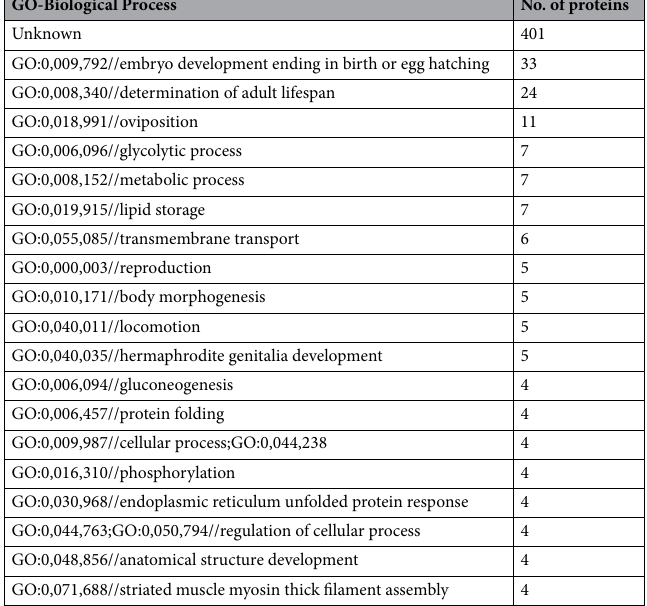
to energy, movement, morphological development, and enzymes for protein structure conformational changes. In addition to GO classification by biological process terms, proteins essential for parasite survival and host immunity evasion were also considered. Proteins relating to oxidation–reduction, proteinase-protease inhibi- tors, structure-movement, and energy were identified in the aL3G protein profile. The top 10 most abundant G. spinigerum proteins involved in these four categories are shown in Fig. 3. Glutathione S-transferase (emPAI of 0.37), peroxiredoxin (emPAI of 0.19), and nucleoredoxin (emPAI of 0.14) were the major antioxidant proteins expressed in aL3Gs. The most prevalent proteases were zinc metalloproteinase nas-14 (emPAI of 1.37), matrix metalloproteinase-like protein (emPAI of 1.13), and cathepsin B-like cysteine proteinase 6 (emPAI of 0.14), while the most abundant protease inhibitors were metalloproteinase inhibitor tag-225 (emPAI of 0.78), serpin I2 (emPAI 0.67), and serpin B4 (emPAI of 0.25). Meanwhile, actin-2 (emPAI of 289.02), actin-5C (emPAI of 6.7), and myoglobin (emPAI of 5.48) were the most highly expressed proteins in the structure-movement group. Additionally, glyceraldehyde-3-phosphate dehydrogenase (emPAI of 2.13), malate dehydrogenase, cytoplasmic (emPAI of 0.61), and phosphoglycerate kinase (emPAI of 0.37) were the main energy-related proteins expressed in aL3Gs. Comparison of aL3G and human protein sequences. To identify potential G. spinigerum drug target candidates, the nucleotide sequences of the 10 most abundant proteins relating to oxidation–reduction, pro- teinase-protease inhibitors, and structure-movement were retrieved from the aL3G transcriptome. The blastx algorithm was used to search the lowest E-value for human proteins in the GenBank database compared with G. spinigerum sequences. The percent homology between G. spinigerum and human sequences is shown in Table 3. According to the alignment results, 10 G. spinigerum proteins including thioredoxin domain-containing protein 15, glutathione transferase omega-2, nucleoredoxin, glutathione S-transferase 1, carboxypeptidase A2,